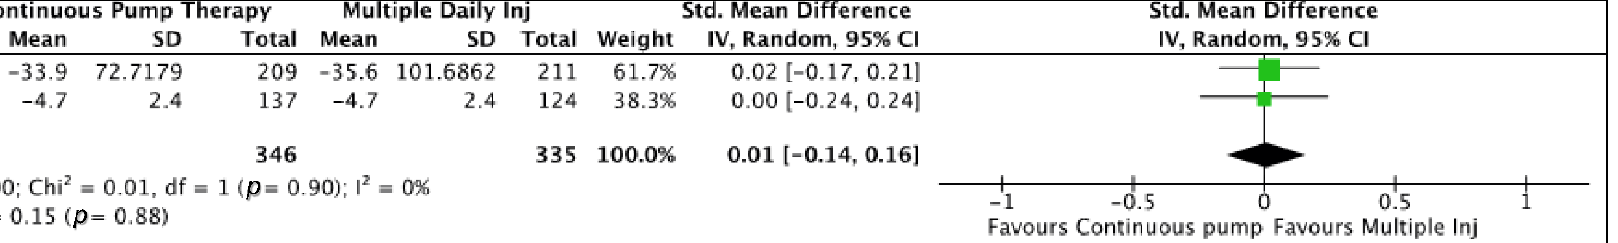
Figure 6. Meta-analysis results and Forest plot for body weight. Figure 7. Meta-analysis results and Forest plot for Daily Insulin Dose.